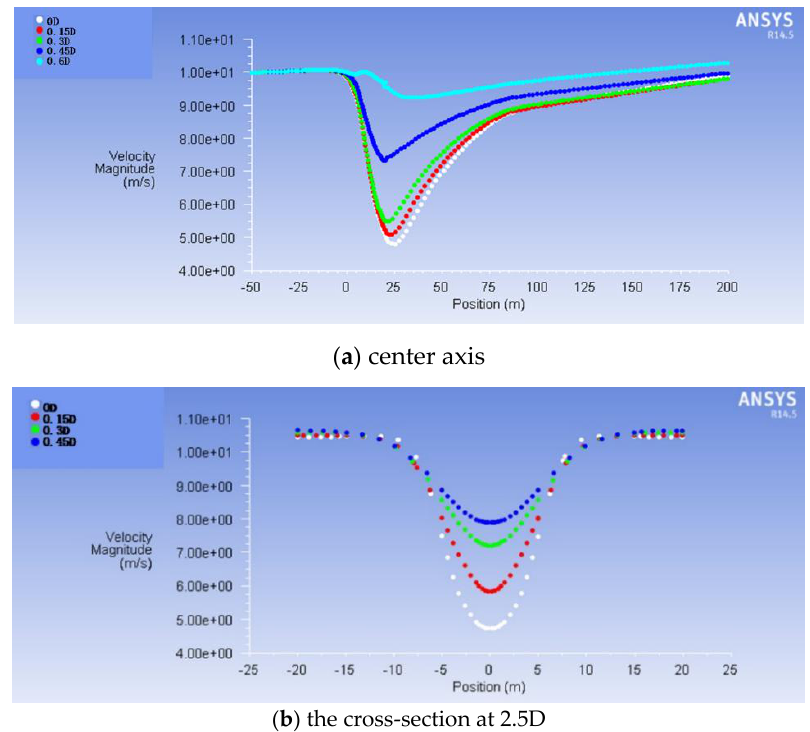
Figure 10. Velocity comparison at 0D, 0.15D, 0.3D and 0.45D heights.